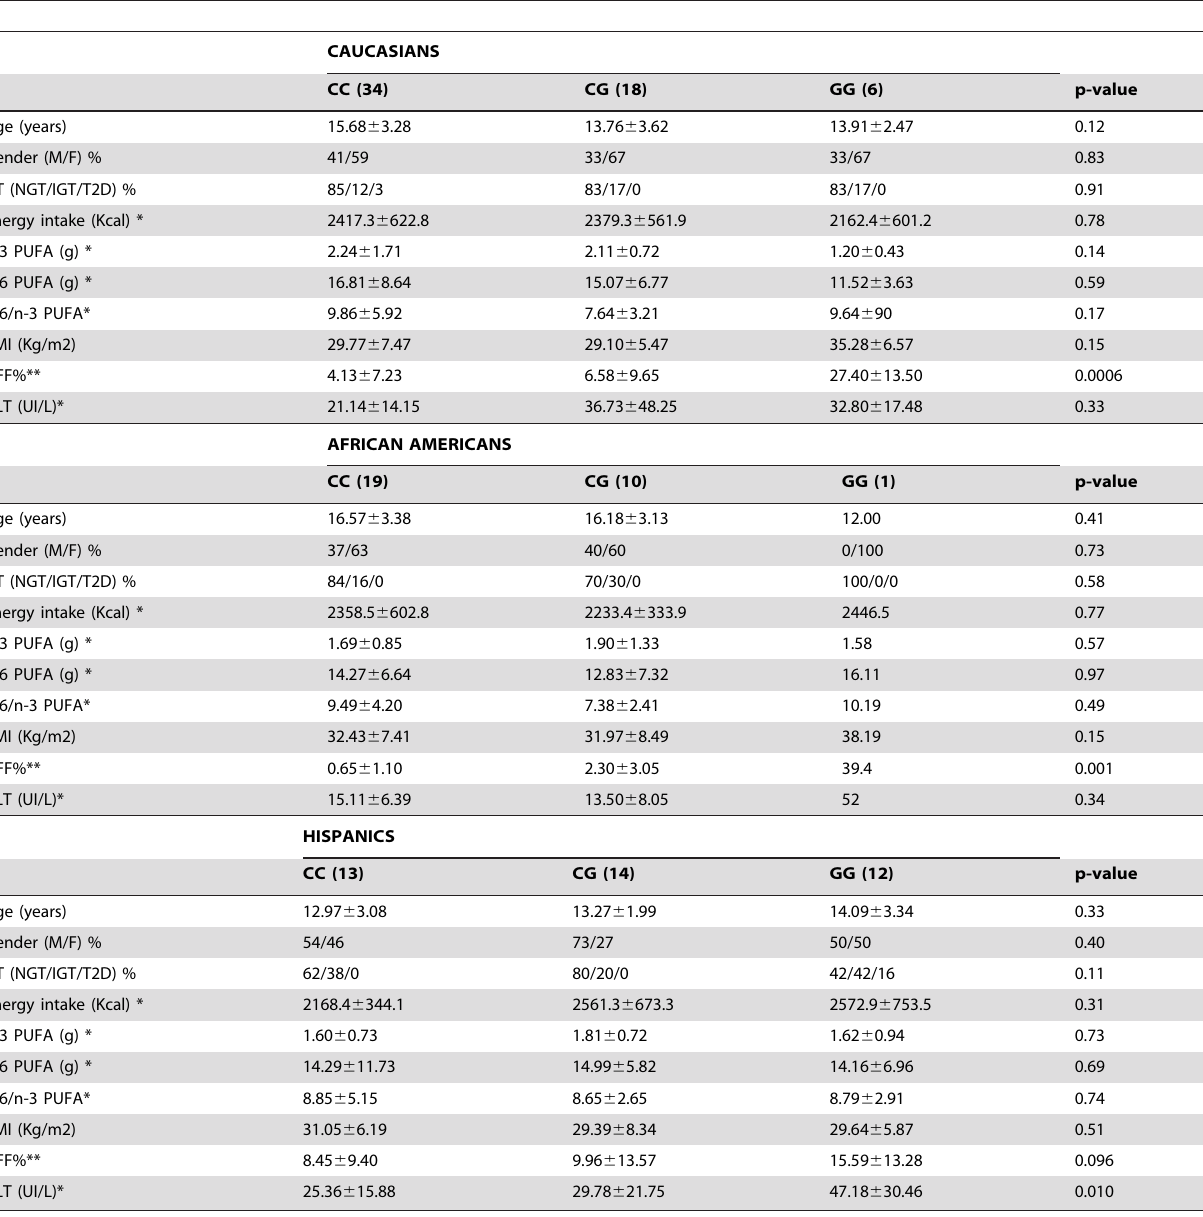
Table 1. Clinical features of the study population according to ethnicity and PNPLA3 rs738409